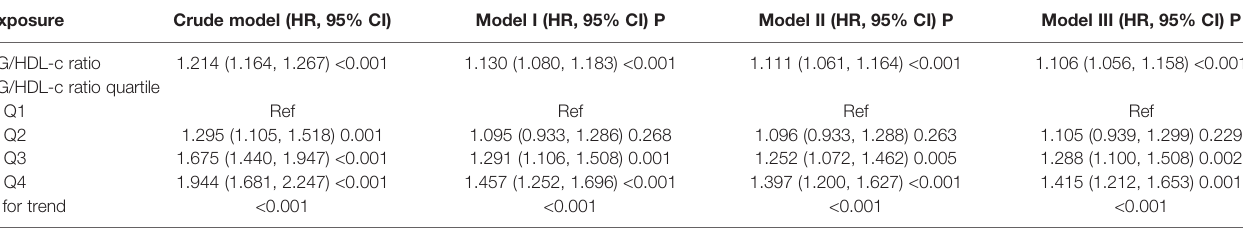
TABLE 4 | Relationship between TG/HDL-c ratio and the risk of diabetes in prediabetic patients in different models. Exposure